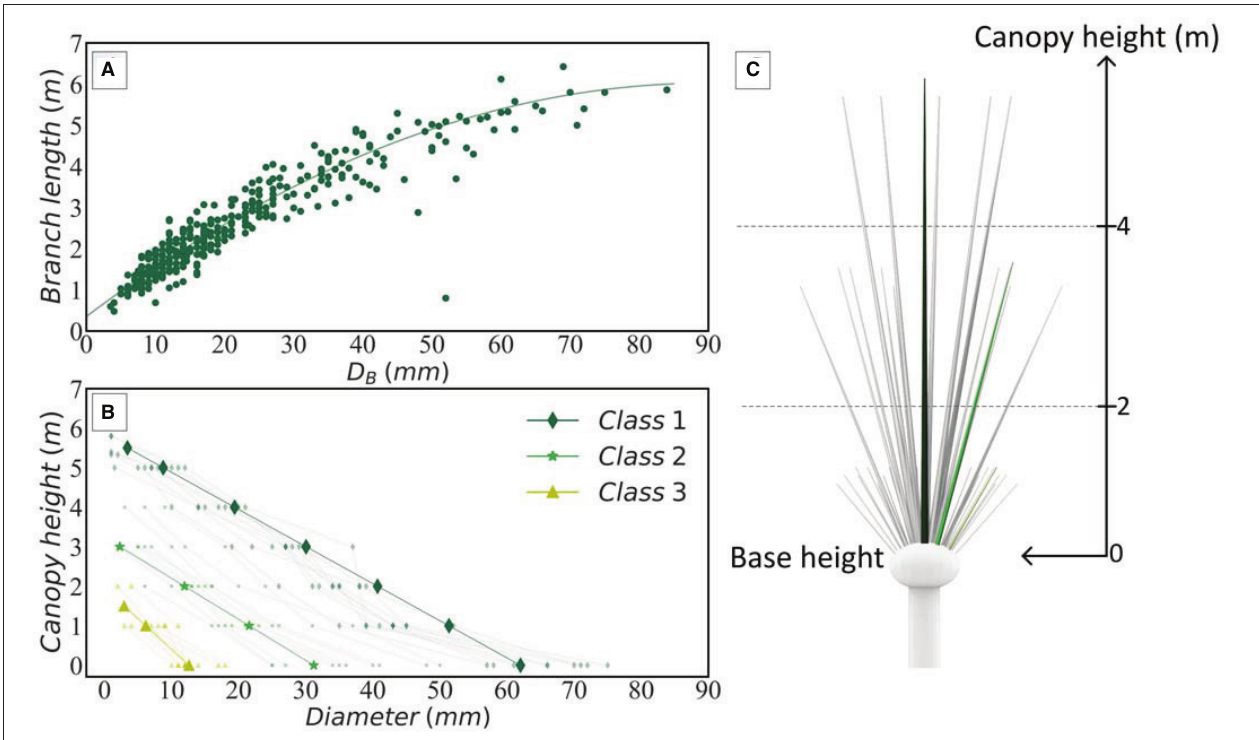
FIGURE 8 | (A) The relation between the diameter at the base of the knot ( D B ) and the branch length for 340 branches (containing all classes), (B) the diameter decay along the length of the branch for 10 branches of each class (class 1, 2, and 3), (C) impression of tree model 1 (i.e., only accounting for main